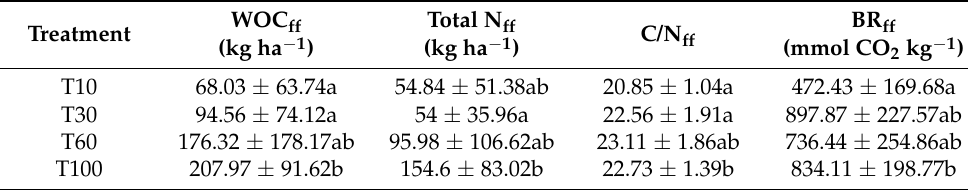
Table 2. Mean ± standard deviation values for soluble organic carbon (WOC ff ), total N ff , C/N ff rela- tionship, and basal respiration for the fine fraction of the forest floor after 28 days of incubation (BR ff ). Lower case letters denote significant differences (Tukey’s HSD/Tamhane’s T2 post hoc tests) for the factor thinning treatment at p -value <0.05.